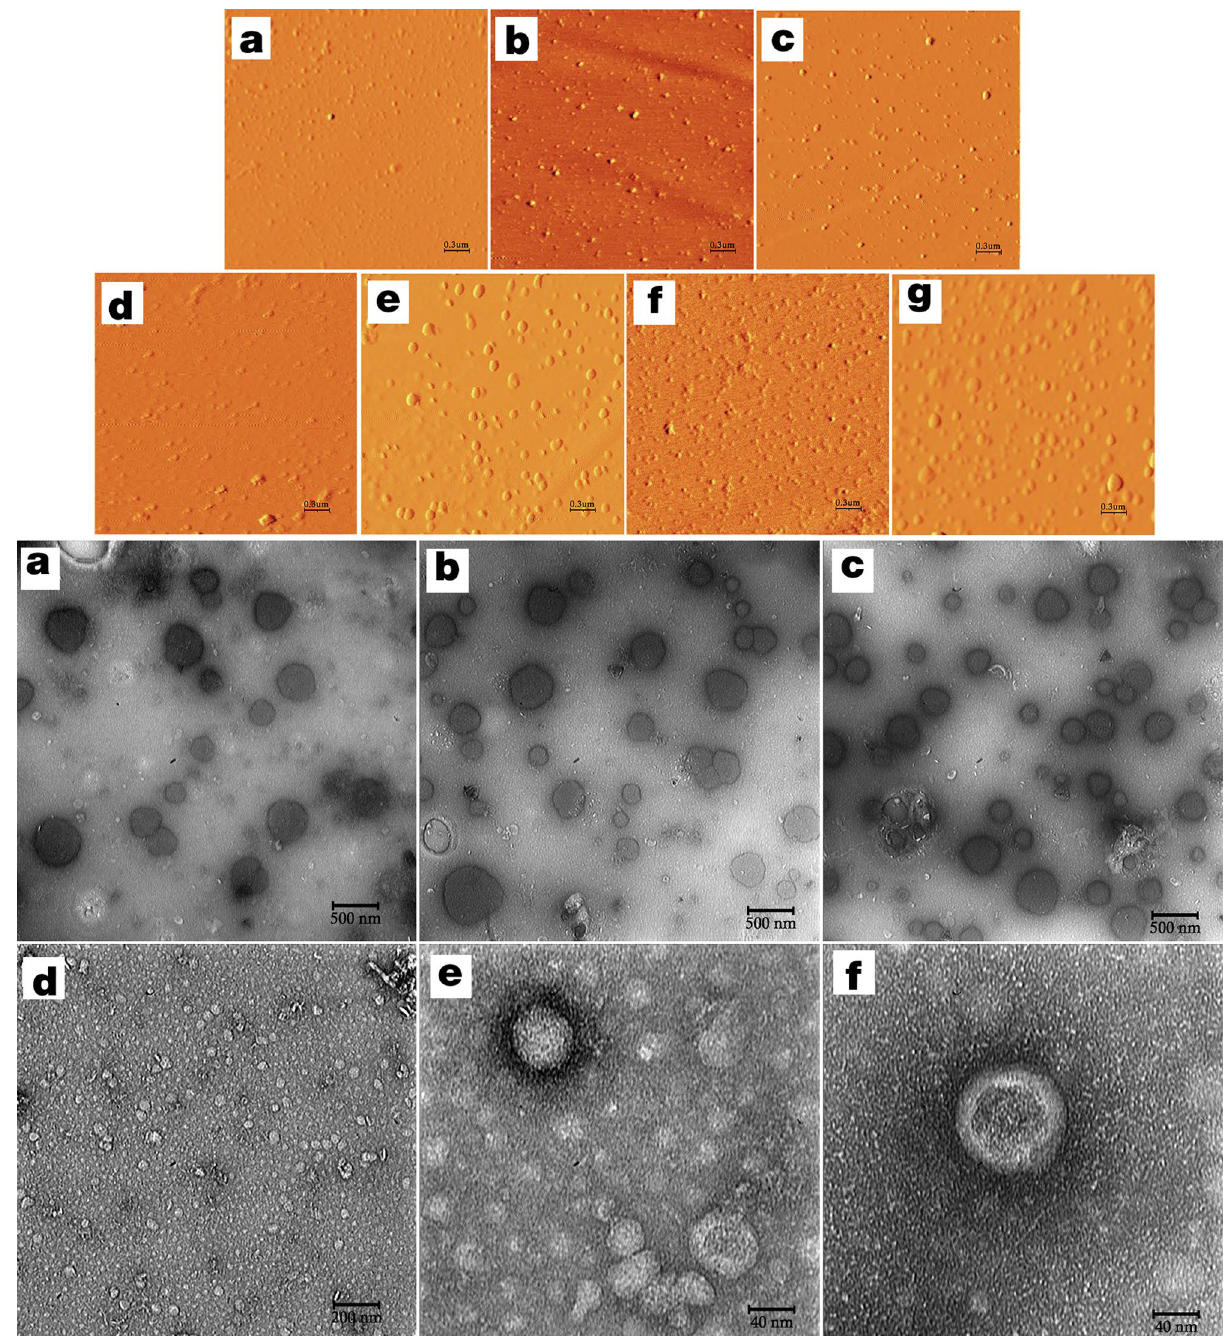
Figure 4. Top; Atomic force microscopy. ( a–c ) represent amplitude images obtained for untreated cells, hTERT- MSCs-IFN-γ (250 U/ml), and hTERT-MSCs-poly(I:C) (20 µg/ml) in scan size range of 3 µm. ( d – g ) represent amplitude images obtained for (hTERT-MSCs)-GFP, -IDO1, -PTGS2 and -TGF-β1, respectively. Three different scan size ranges including 3, 5 and 10 µm were applied for the AFM studies. Image processing and analysis were performed by Imager version 1.00 AraResearch Co. Bottom; Electron micrographs from three hTERT- MSCs-GFP derived EV samples ( a–c ) using transmission electron microscopy (Leo 912ab, Zeiss, Germany, 120 kV, Tungsten filament, holy carbon film grid). As demonstrated the vesicle-like particles of different sizes (50–200 nm) as well as lipid bilayer membranes of intact spherical EVs are prominent. ( d–f ) Transmission electron micrographs obtained from PEG-concentrated ultracentrifuge supernatants (20-fold) of the untreated